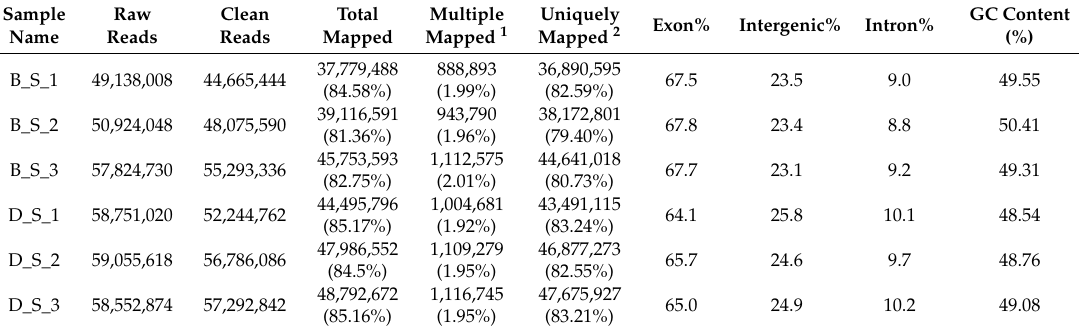
Table 1. Characteristics of the reads from spleen libraries obtained from 2